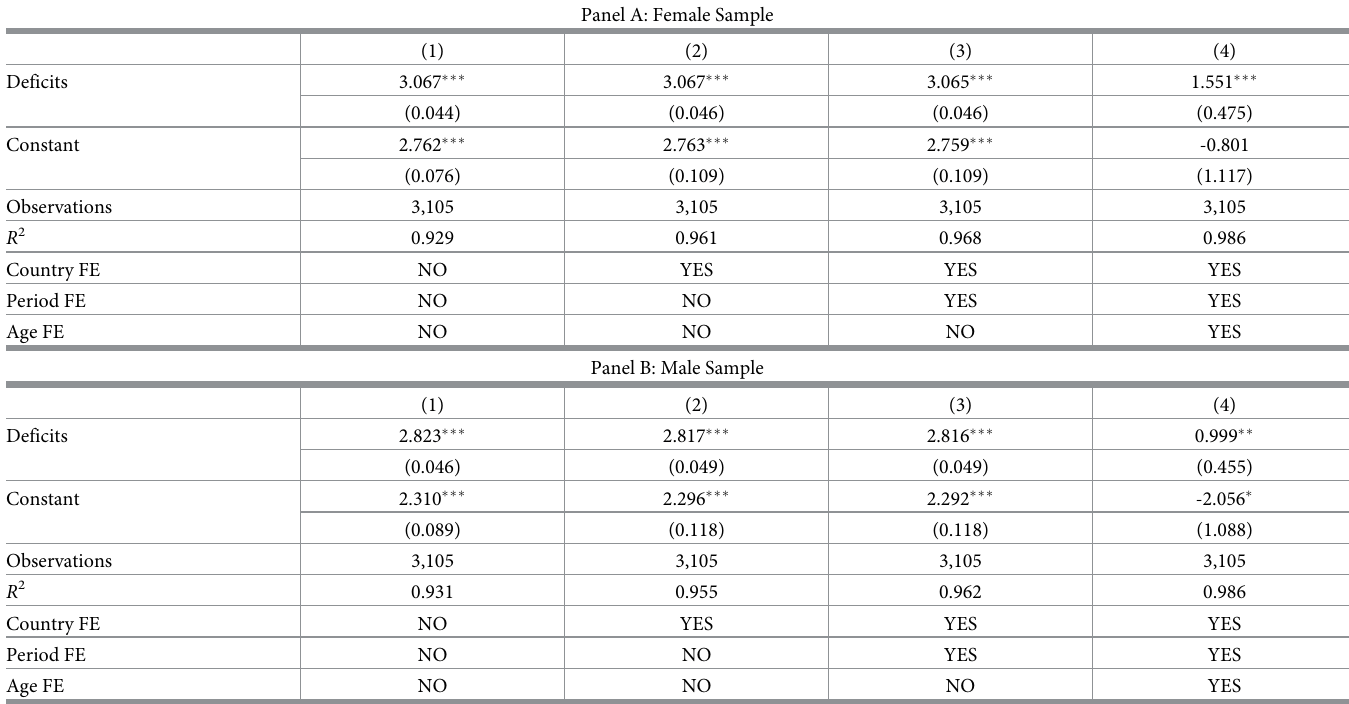
Table 2. Estimated frailty-mortality